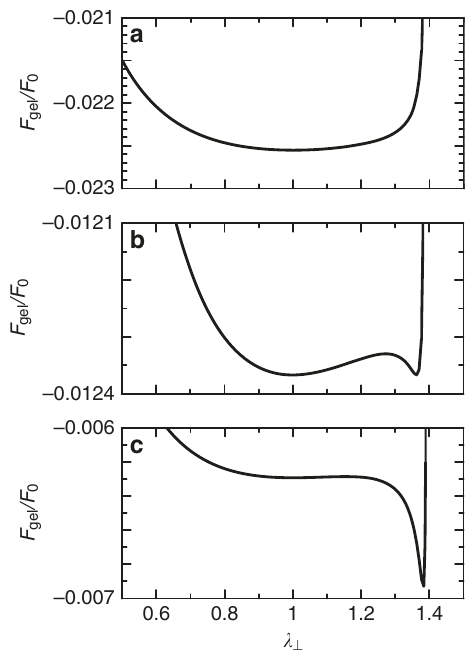
Fig. 2 Free energy F gel per a unit cell vs the extension ratio λ ⊥ . The free energy F gel per a unit cell (rescaled by F function of the extension ratio λ ⊥ in the normal of the nanosheets for several values of the interaction parameter χ ; a χ = 0.3, b 0.6132, and c 0.8. The values of parameters that are used for the calculations are s ( = ( r ex − r in )/ r in ) = 0.2 and g 0 = 1.0 × 10 − 3 (see Fig. 1 and Eq. (9) for the de fi